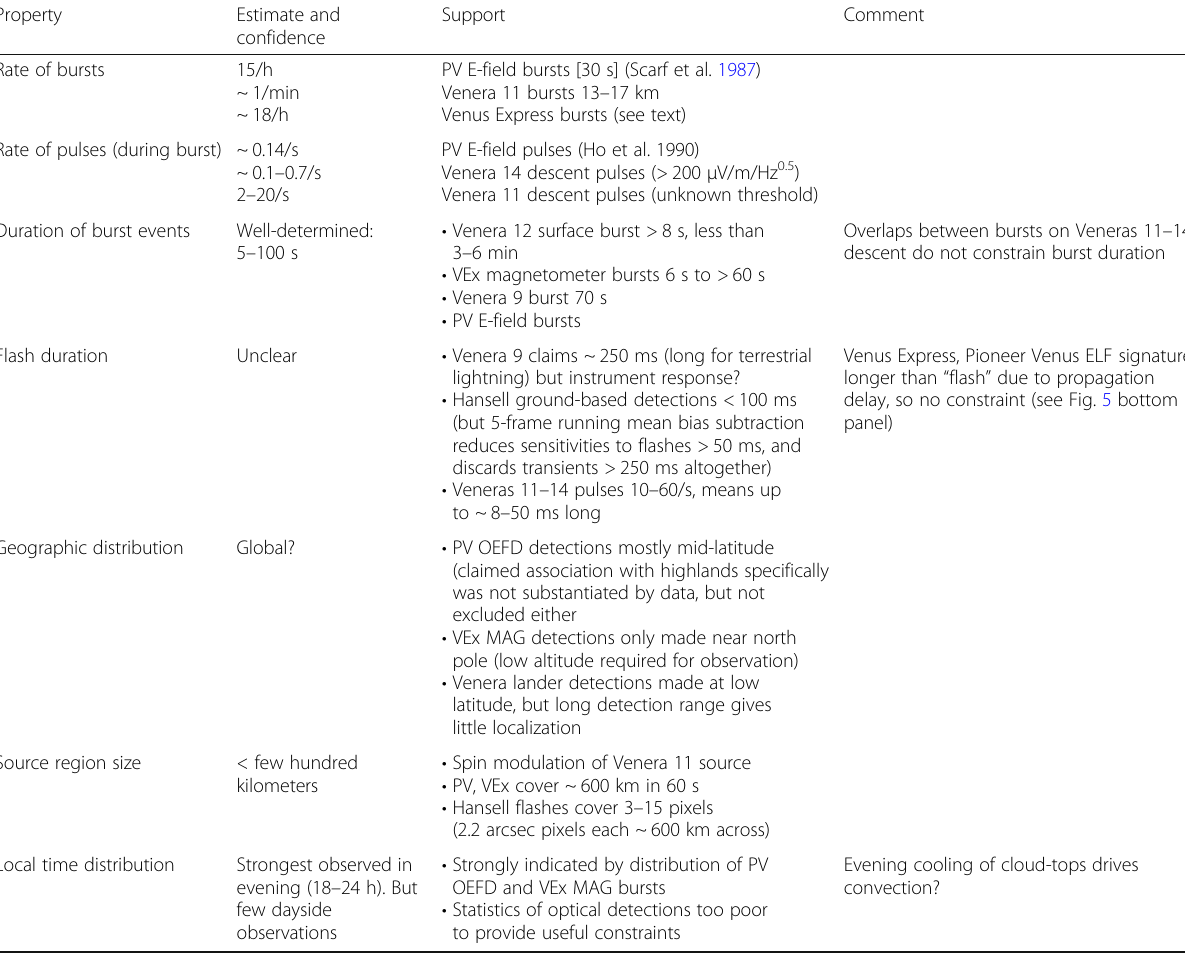
Table 3 Summary of characteristics of Venus electrical activity